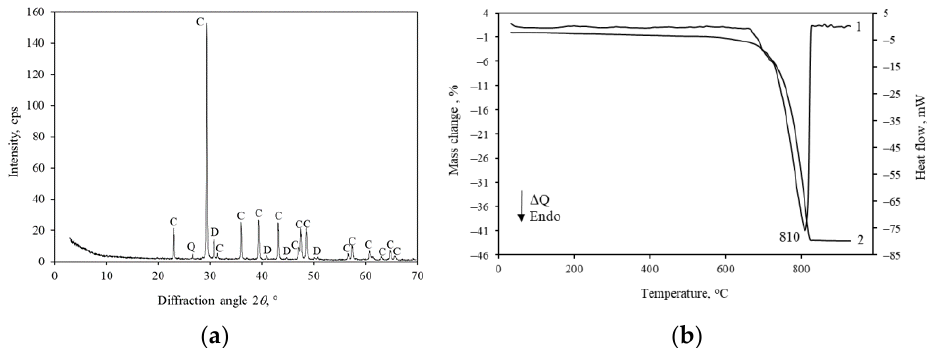
Figure 2. XRD pattern ( a ) and STA curves ( b ; 1—DSC, 2—TG) of Karpenai limestone. Indexes: C—calcite, D—dolomite, Q—quartz.